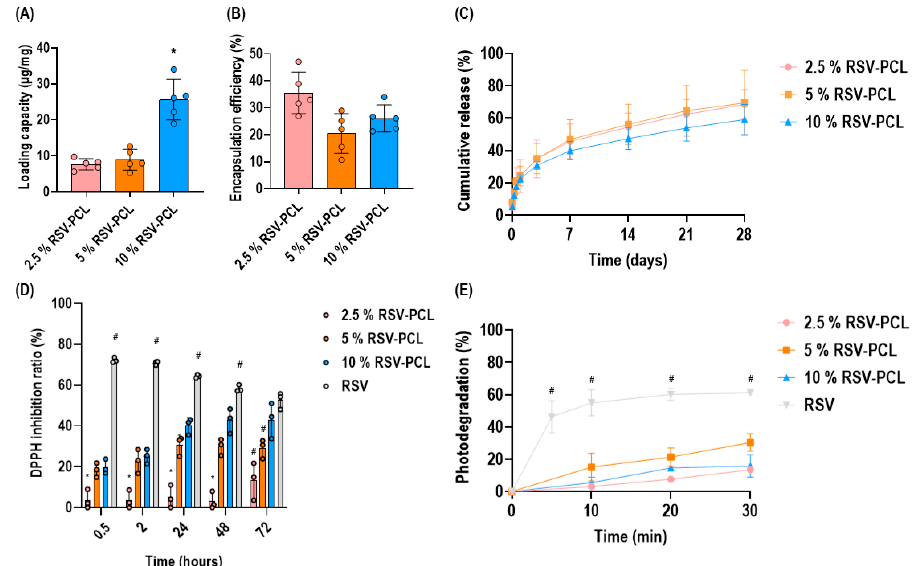
Figure 3. Drug content, drug release, photodegradation, and antioxidant analyses of RSV-PCL electrosprayed microparticles. Loading capacity analysis ( A ) revealed that 10% RSV-PCL had the highest ( p < 0.05) loading capacity ( n = 3 batches). Encapsulation efficiency analysis ( B ) showed no statistically significant ( p > 0.05) differences among all microparticles. Cumulative release analysis ( C ) revealed that all microparticles reached approximately 60% cumulative release after 28 days ( n = 3 batches). DPPH radical scavenging activity analysis ( D ) revealed that RSV-loaded microparticles showed an increase in antioxidant capacity as a function of time while pure RSV lost its antioxidant properties over time ( n = 3 batches). Photodegradation analysis ( E ) showed that PCL microparticles significantly ( p < 0.05) reduced RSV photodegradation at all time points in comparison to pure RSV powder control ( n = 3 batches). * indicates a statistically significant difference among RSV-PCL microparticles ( p < 0.05). # indicates a statistically significant difference between pure RSV powder and RSV-PCL microparticles ( p < 0.05). Individual values are displayed as dots on bar charts. Error bars represent mean ± SD. Generalized linear models and bootstrap- t